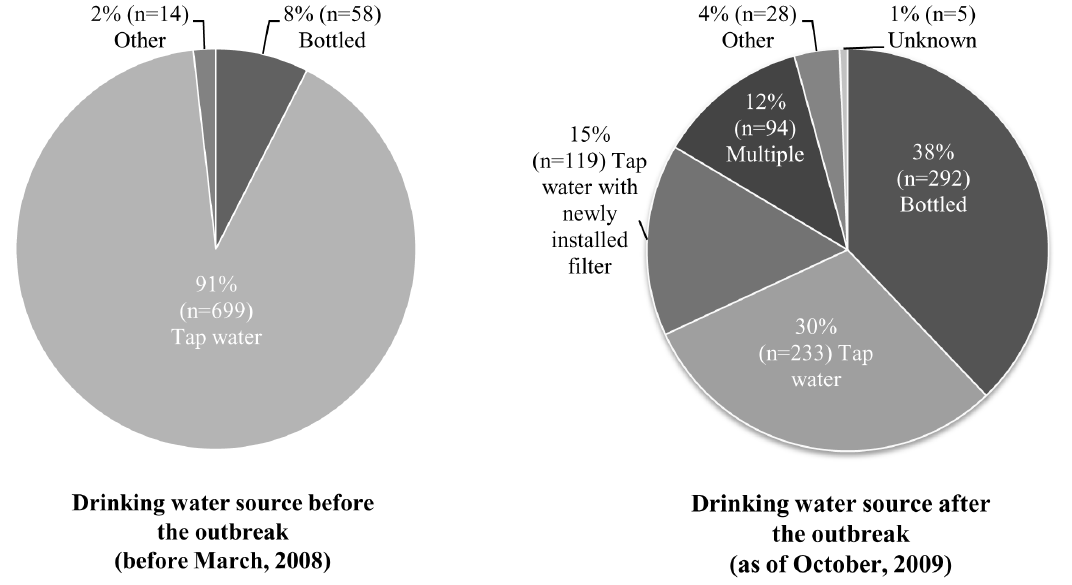
Figure 2. Change in water source after the outbreak (n=771 households) following an outbreak of salmonellosis, Alamosa, Colorado